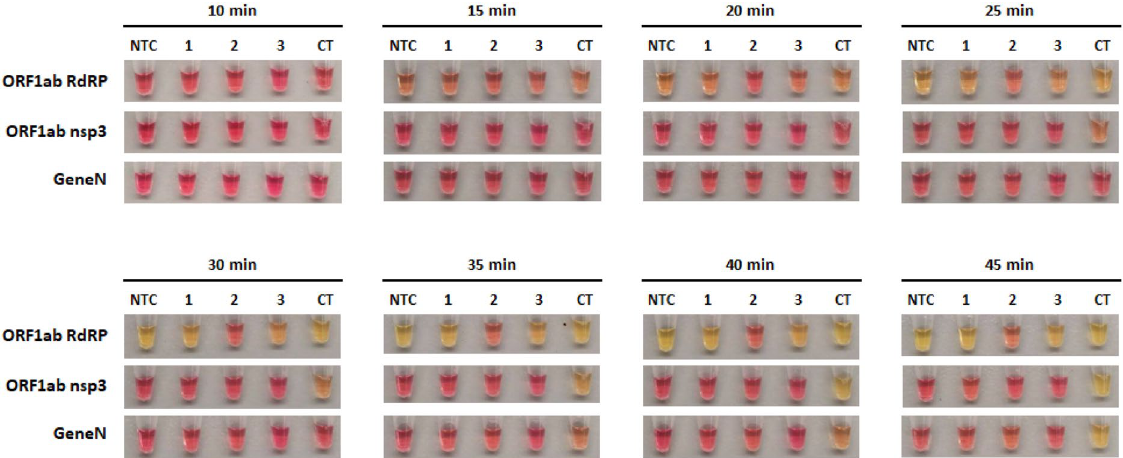
Figure 7. False-positive testing of RT-LAMP in clinical saliva samples. RT-LAMP reactions are assessed at different time points in saliva samples from 3 healthy patients (1–3). NTC indicates no template control as a negative control. CT indicates positive control using Twist Synthetic SARS-CoV-2 RNA (10,000 copies). n = 3 independent experiments.